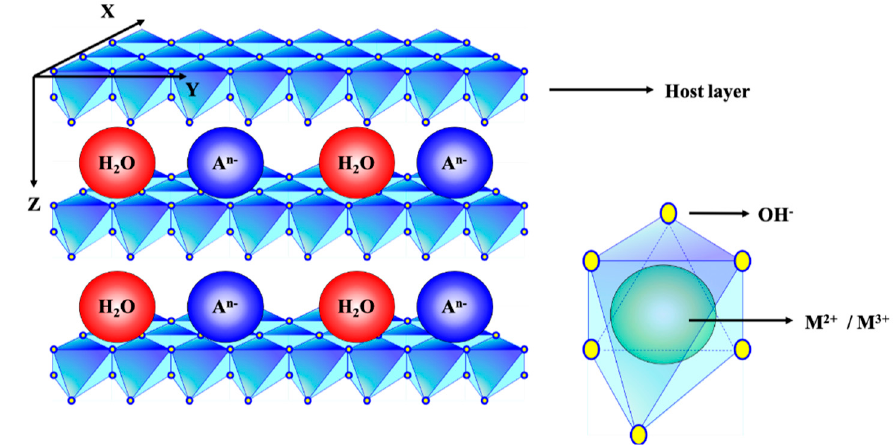
Figure 1. Structure of layered double hydroxides.